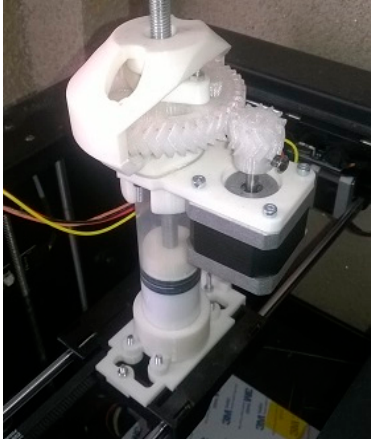
Figure 10. Paste extruder prototype.